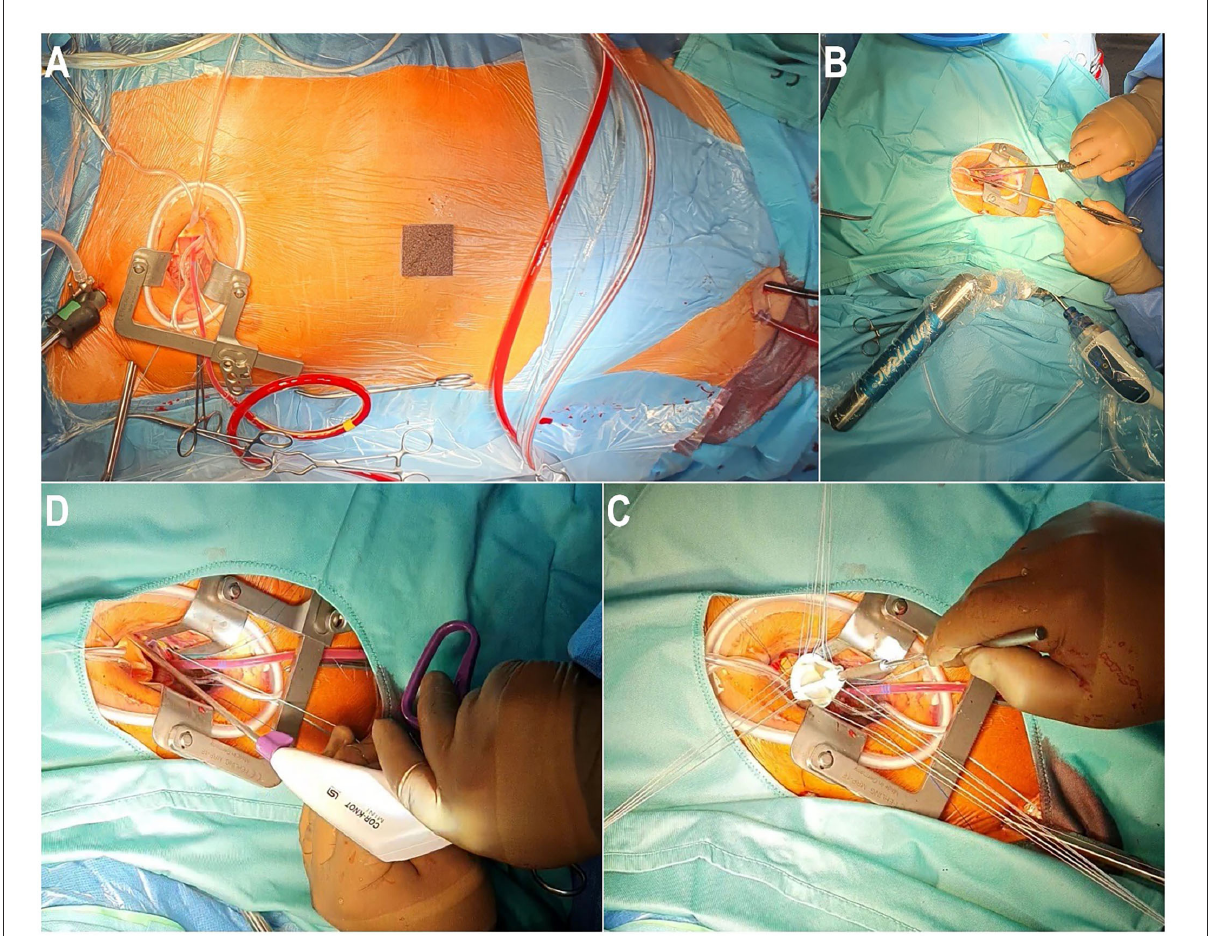
FIGURE1 Operative setup of an endoscopic aortic valve replacement through right anterior mini-thoracotomy. (A) Right anterior mini-thoracotomy with percutaneous cannulation of the cardiopulmonary bypass. (B) Endoscopic placement of the aortic annular suture using long shaft instruments. (C) Implantation of the aortic valve prosthesis. (D) Introduction of Cor-Knot ® to fix the aortic valve